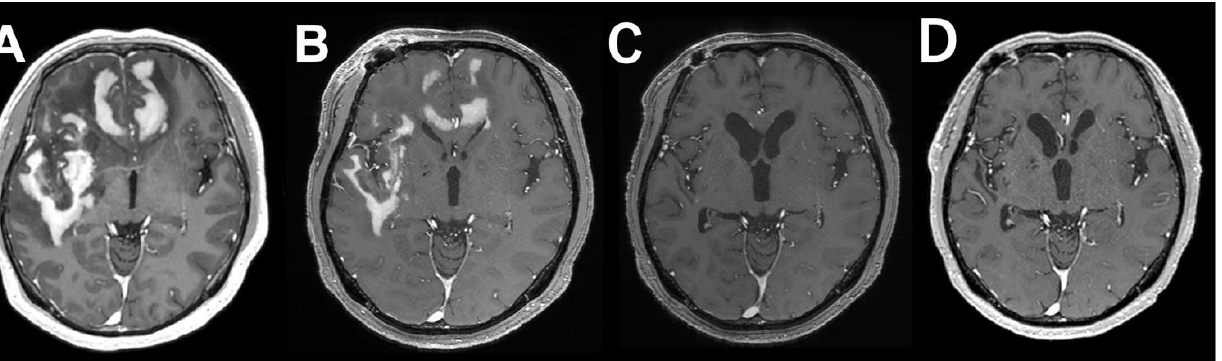
Figure 3. Post-contrast MR images showing a dramatic response to steroids and chemotherapy. ( A ) At presentation. ( B ) After steroid treatment. ( C ) After three cycles of methotrexate (MTX). ( D ) After five cycles of MTX.